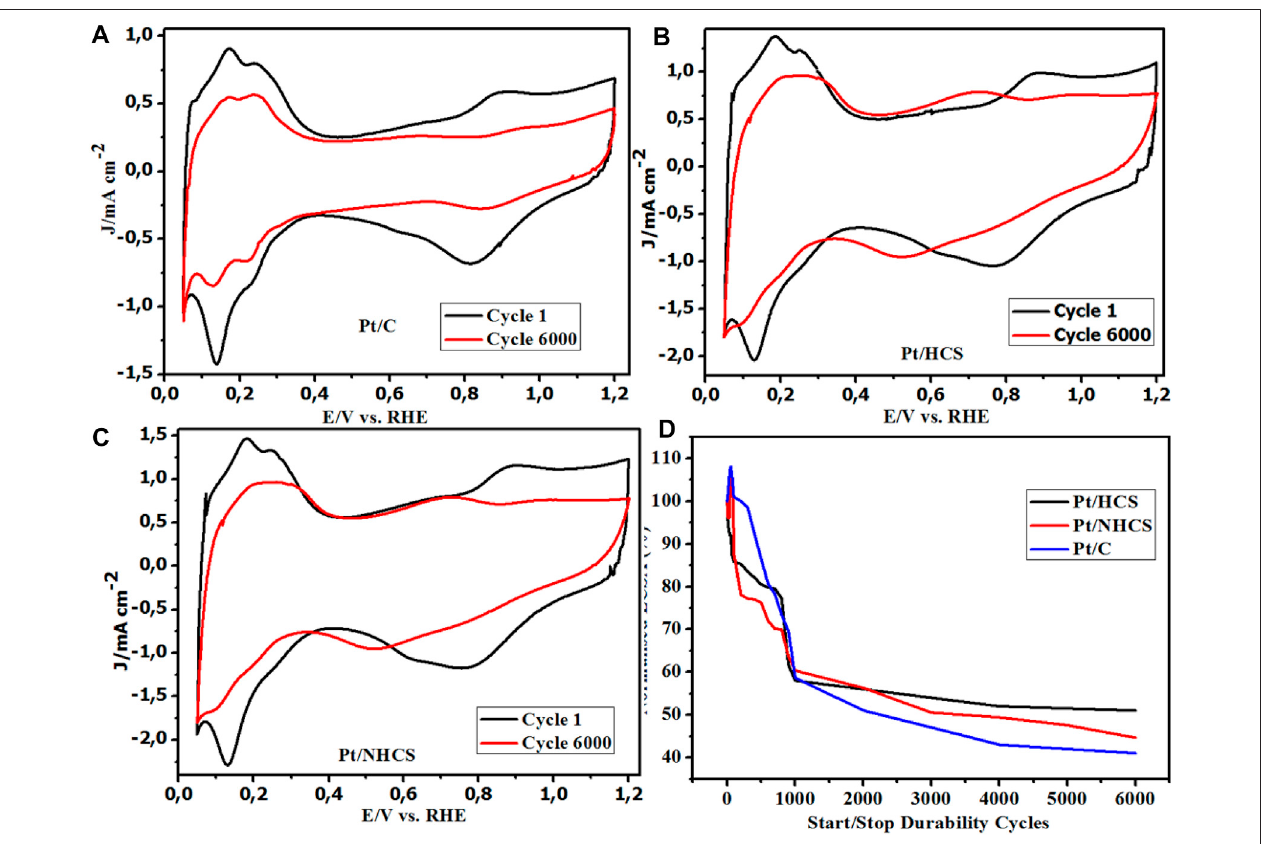
FIGURE 8 | (A – D) Catalyst CVs before and after durability studies for the Pt/HCSs, Pt/NHCSs and the commercial benchmark Pt/C catalysts, (D) Normalized ECSA% degradation of the